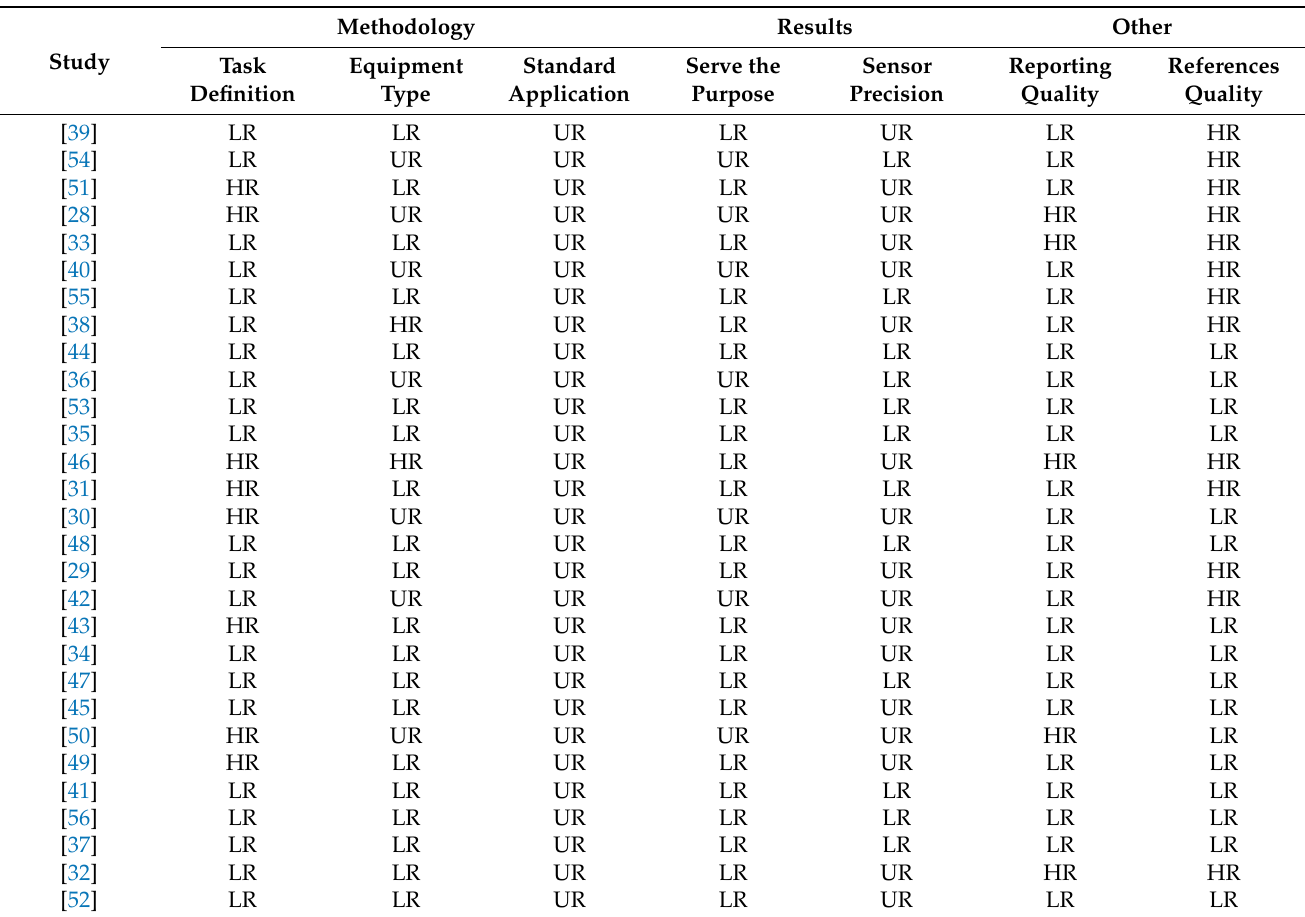
Table 2. Risk of